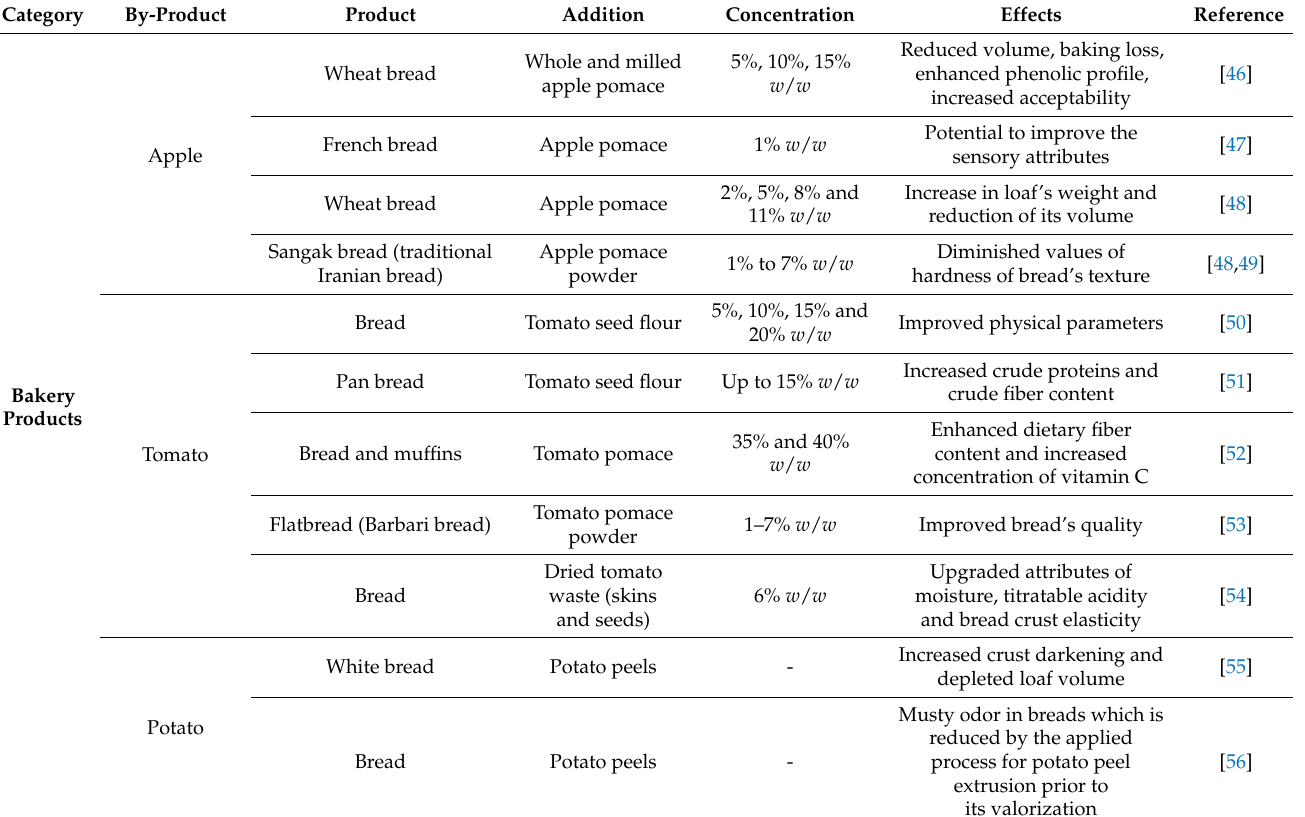
Table 2. Addition of agri-food by-products to bakery